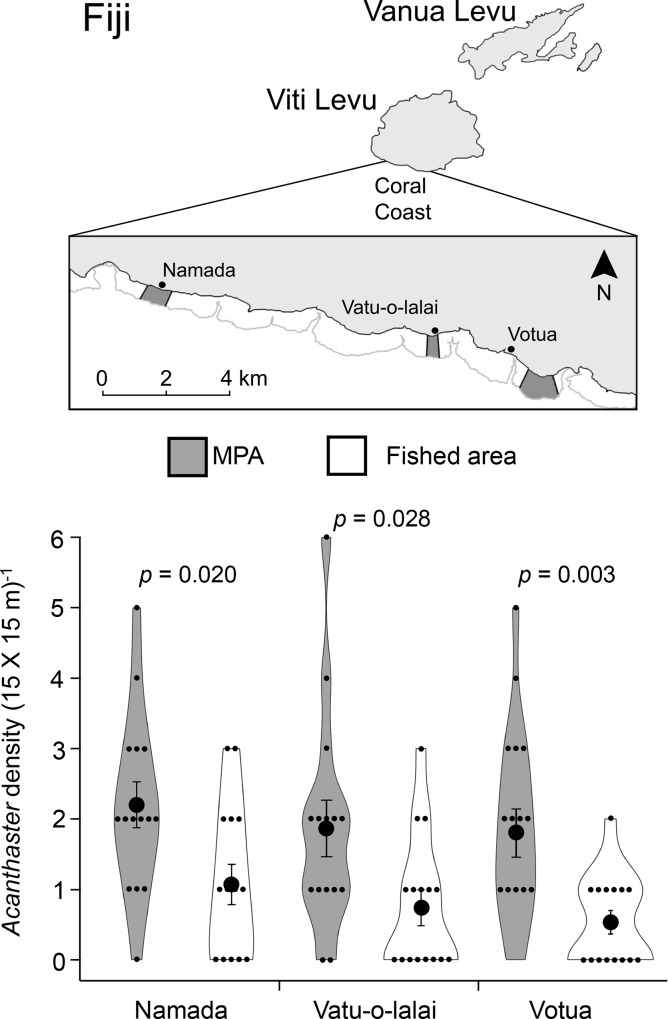
Mean Acanthaster density is ~2–3.4 times greater within Marine Protected Areas (MPAs) than adjacent fished areas.(Top panel) Village and MPA locations along the coast of Viti Levu, Fiji. Dark gray sections represent the MPAs at each site. (Bottom panel) Violin plots depicting the mean ± SE Acanthaster density (large black dots and error bars), the frequency of plots with differing densities of Acanthaster (the enclosed areas), and each individual plot as a function of Acanthaster counted in that 15 X 15 m plot (small black dots) within MPAs (dark gray) and adjacent fished areas (white) at each village (n = 15 quadrats reef-1 location-1). Data for each pairwise comparison were analyzed using a generalized linear model (GLM) with a Poisson distribution (Votua) or quasi-GLM models (Namada and Vatu-o-lalai).